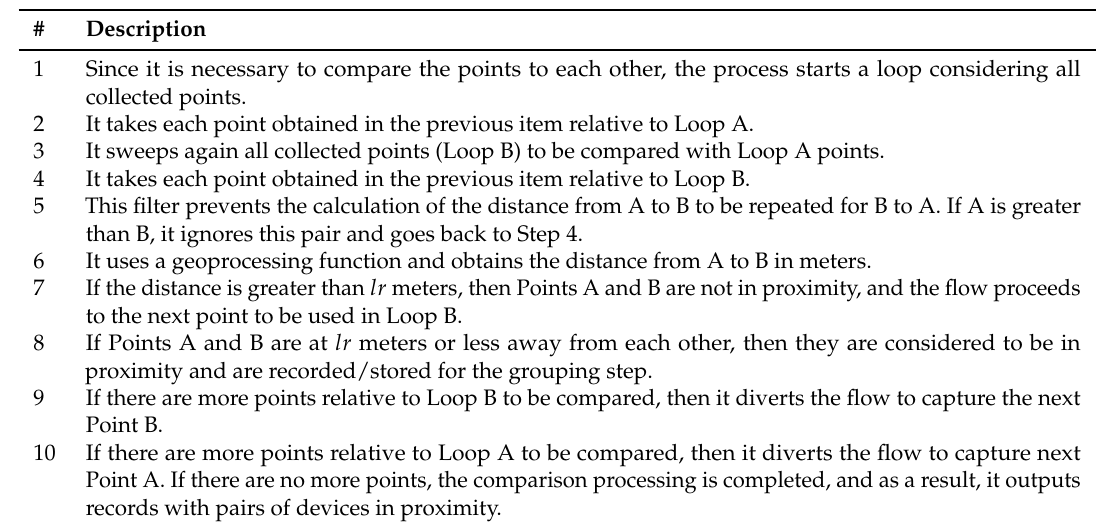
Table 3. Detailed steps of Algorithm 1 (detection of pairs).